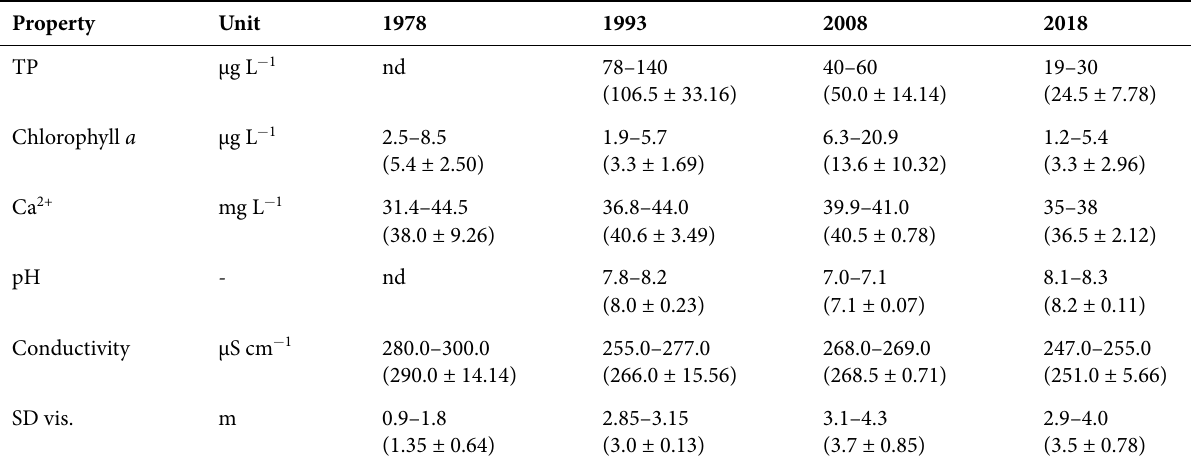
Table 1 Decadal changes in the physical and chemical properties of Lake Kuźnickie pelagic waters.